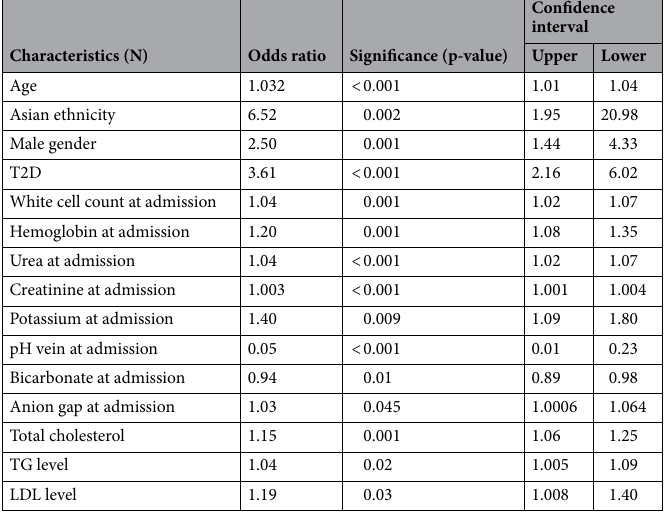
Table 4. Univariate analysis for factors associated with the development of concomitant DKA with AP. DKA Diabetic ketoacidosis, AP acute pancreatitis, LDL low-density lipoprotein, TG triglyceride.